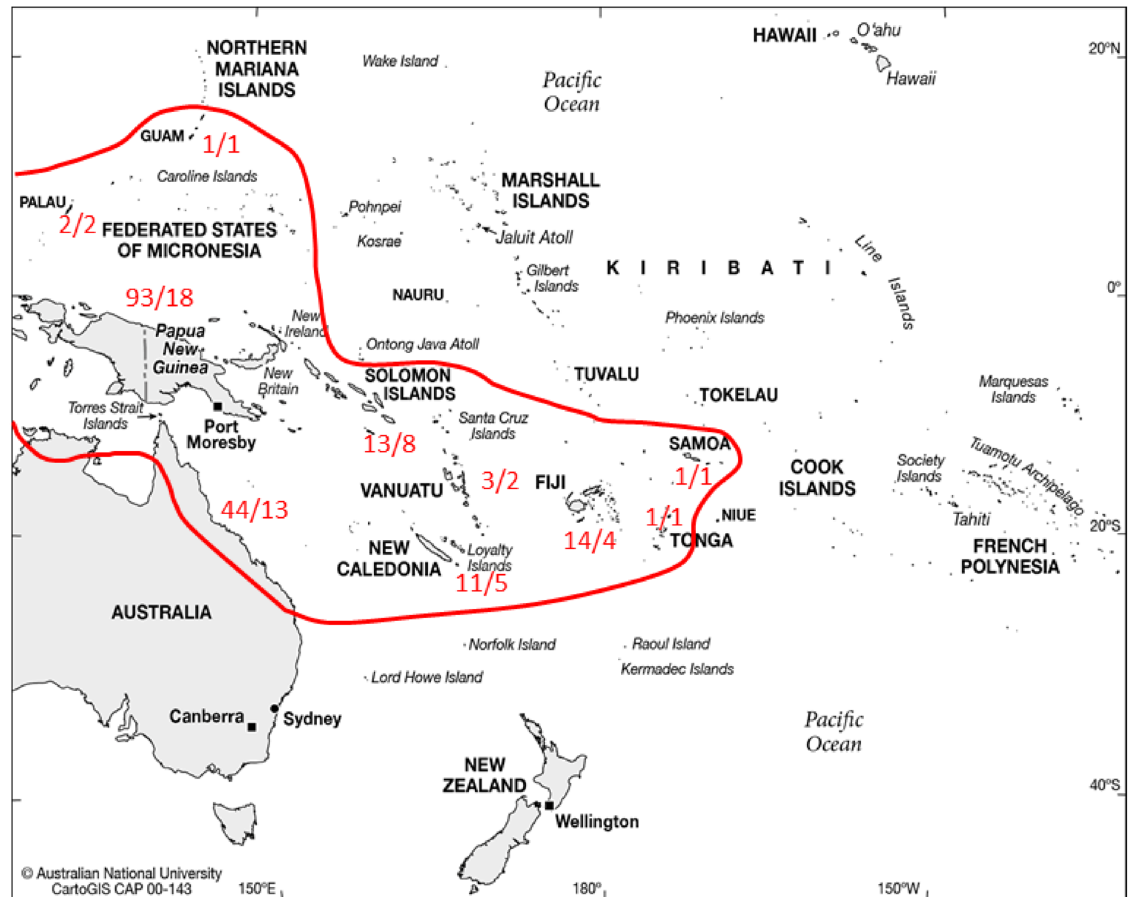
Fig. 20. Regional distribution of the Annonaceae in the Pacific. The numbers next to each island or island group represents the number of native Annonaceae species and genera found there (number of species/number of genera). The numbers for New Guinea remain approximate. The numbers for the Solomon Islands include Bougainville and the Santa Cruz Islands. Base map sourced from CartoGIS, College of Asia and the Pacific, The Australian National University,